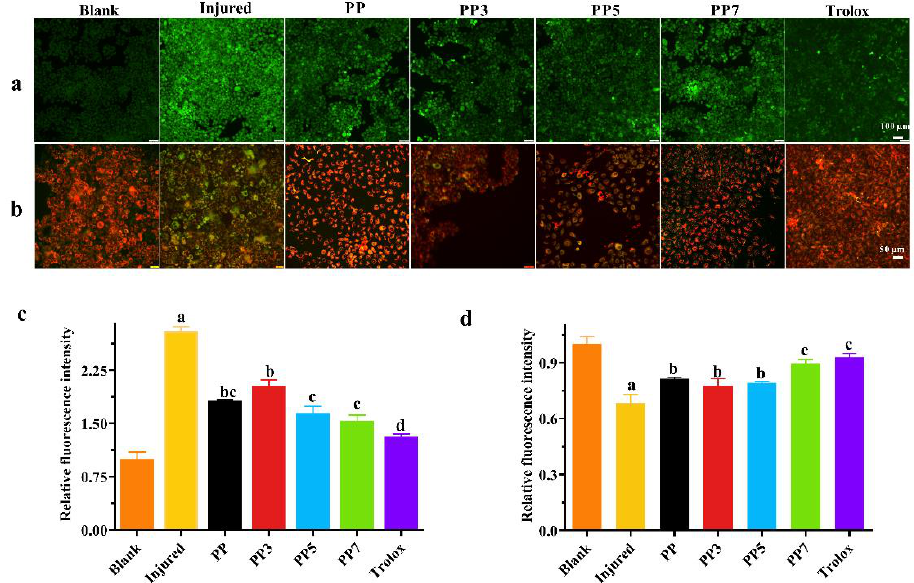
Figure 9. Treatment of PP, PP3, PP5, and PP7 significantly alleviates apoptosis by inhibiting intra-cellular ROS levels in HHL-5 cells, and different letters in the picture indicate significance, p < 0.05. ( a ) The depolarization of the mitochondria membrane induced the release of JC-1 from mitochon- dria to form JC-1 monomers. ( b ) JC-1 accumulated in mitochondria as JC-1 aggregates when the mitochondria membrane was intact. ( c ) The intracellular ROS contents in HHL-5 cells under ju- glone-induced oxidative stress. ( d ) Quantitative evaluation of JC-1 aggregates/monomers ratio.